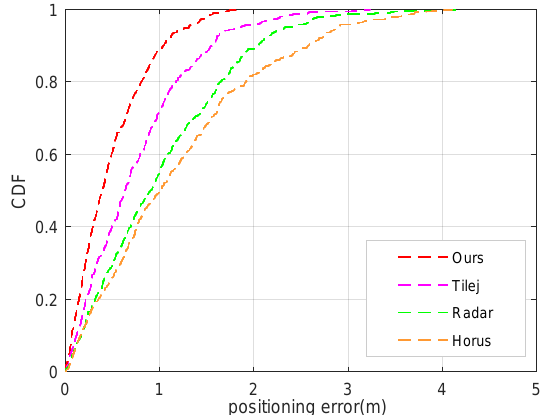
Figure 10. Cumulative distribution of localization